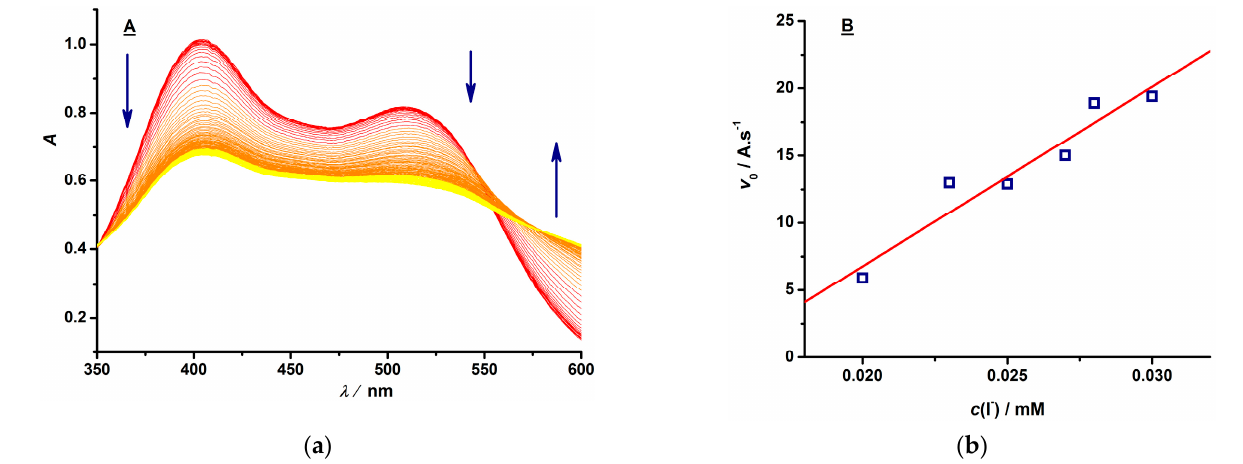
Figure 4. Time dependence of change of absorption spectra for the system Tl(III) –PAR–I – (Tl(III):PAR = 1:2, c Tl = 5.10 − 5 M, c I = 3.10 − 5 M, ∆ t = 6 s) ( a ) recorded at wavelength 520 nm, which was used for the construction of a calibration plot initial rate = f( c I ) ( b ).